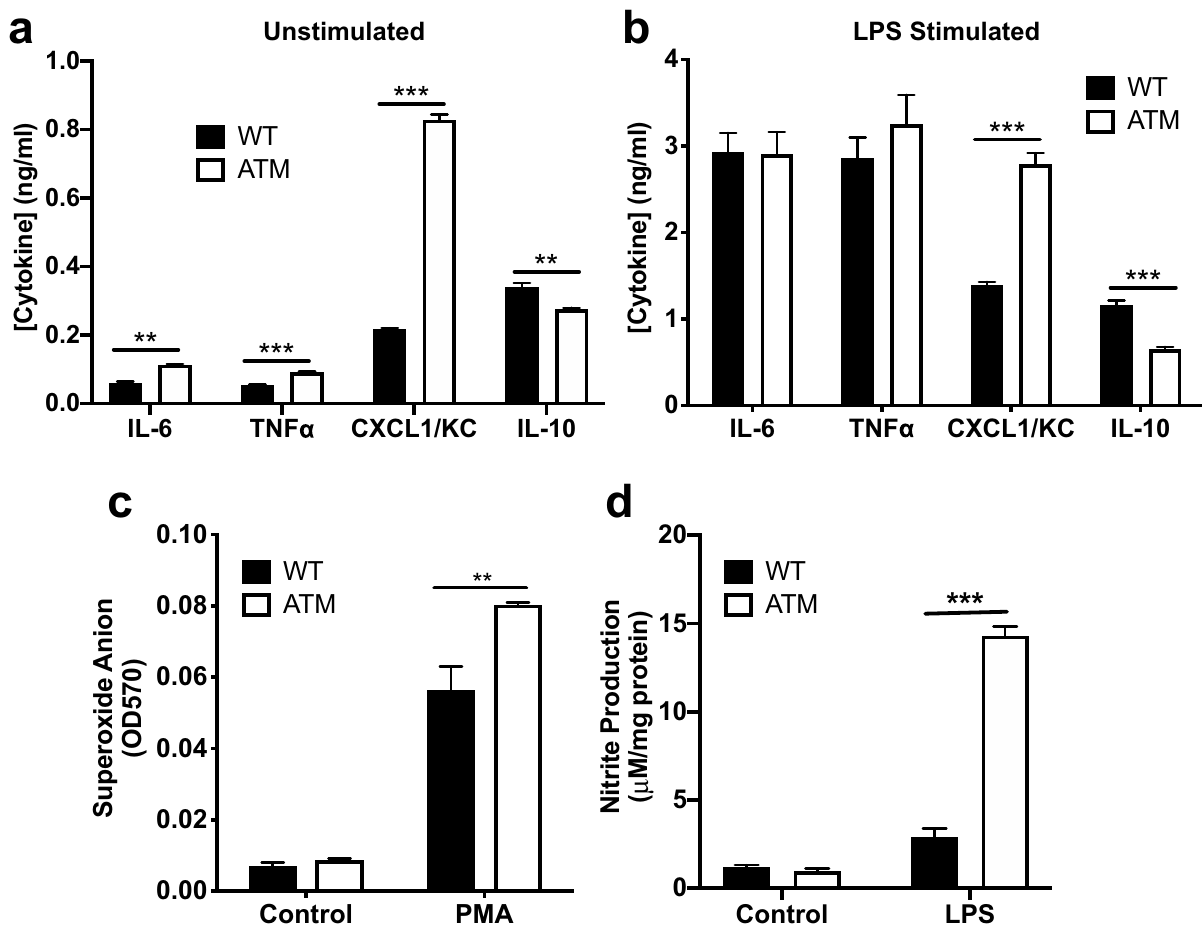
Figure 4. ATM-deficient macrophages exhibit aberrant production of chemokines and cytokines and elevated levels of reactive species. ( a ) Primary macrophages derived from bone marrow isolated from WT or ATM ∆/∆ mice were cultured, and levels of the indicated cytokines and chemokines were measured in cell culture supernatants by ELISA. ( b ) Bone marrow derived macrophages were stimulated with LPS (1 μg/mL), and the cytokine and chemokine levels were determined at 24 hr post-stimulation. ( c ) Intracellular superoxide anion (O 2 − ) in WT and ATM ∆/∆ primary macrophages was quantitated in PMA (1 μg/mL) + ionomycin (1 μg/mL) stimulated cultures (30 min) and unstimulated (control) cultures using a modified nitroblue tetrazolium assay. ( d ) NO 2 levels, as a measure of RNS, were quantitated in supernatants from cultured unstimulated and LPS- stimulated WT or ATM ∆/∆ primary macrophages using the Greiss assay. P ≤ 0.01 for unstimulated vs. stimulated cultures in ( c , d ). Data were obtained from a minimum of 3 independent experiments; Bars, mean ± SEM; **P ≤ 0.01; ***P ≤ 0.001. Figure 5. Impact of reparixin treatment on aberrant inflammatory responses in ATM-deficient mice. Bleomycin-instilled ATM ∆/∆ and WT mice received intraperitoneal injections of either reparixin or saline twice daily for a period of 7 days. BAL fluid collection and analysis occurred on d14 post-instillation. ( a ) Protein concentrations in BAL fluid were determined using the bicinchoninic acid assay at d14 post-instillation. ( b ) Live BAL cells (× 10 6 ) were quantitated by counting using a hemocytometer and staining with the viability dye, Trypan Blue. ( c ) TNF-α levels were measured in BALs via ELISA from reparixin treated WT and ATM ∆/∆ mice and controls. ( d ) Percentages of neutrophils in the BALs from reparixin or saline treated WT and ATM ∆/∆ mice were assessed by flow cytometry at d14 post-bleomycin. Dotted line, % neutrophils in control saline-instilled lungs. ( e ) TUNEL positive cells in 6 arbitrarily selected microscopic fields of lung sections of WT and ATM ∆/∆ mice at d14 post-bleomycin were quantitated. Number of animals: Saline: WT, n = 5; ATM ∆/∆ , n = 7; Reparixin: WT, n = 10; ATM ∆/∆ , n = 10. Dotted line, % TUNEL + cells in control saline-instilled lungs. Bars, mean ± SEM; *P ≤ 0.05; **P ≤ 0.01; ***P ≤ 0.001.